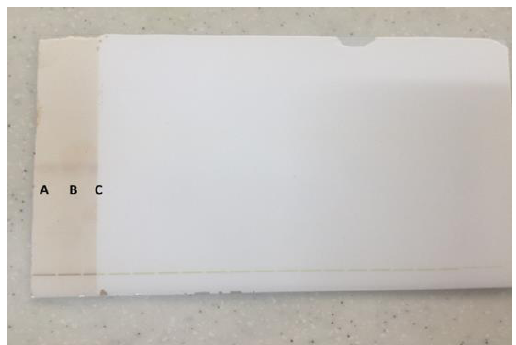
Fig. 3. TLC for ethyl acetate fraction, A: ethyl acetate fraction, B: Rutin (standard), mobile phase: chloroform: methanol: formic acid (15: 4: 1). 3- HPTLC Analysis: hexane: ethyl acetate (50: 50) and revealed the (RF) with standard of stigma-sterol as shown in Figure 4.